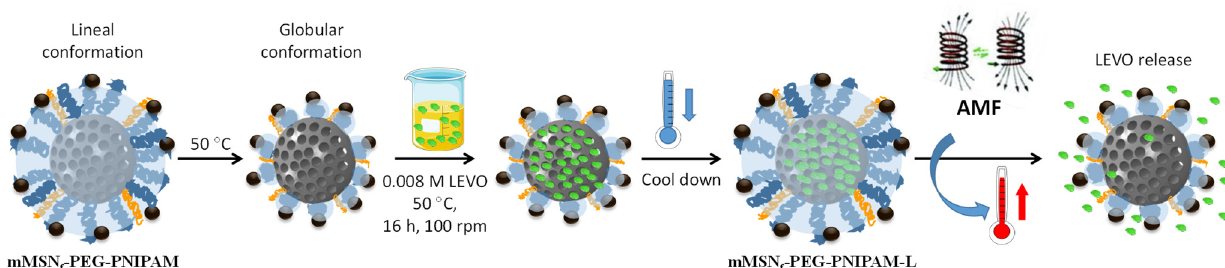
Figure 4. Schematic depiction of the experimental procedures carried out for the loading and release of LEVO from the mMSNf-PEG-PNIPAM nanosystem. Briefly, the nanosystem was soaked into a LEVO solution in EtOH at 50 °C to bring the polymer into globular conformation and allow LEVO loading into the mesopores. Then, the cool down favors the polymer adopting the expanded conformation to close the pores and prevent antibiotic release. Finally, the application of an AMF produces an increase in the local temperature that provokes a conformational change in the polymer from linear to globular, which triggers pore uncapping and LEVO